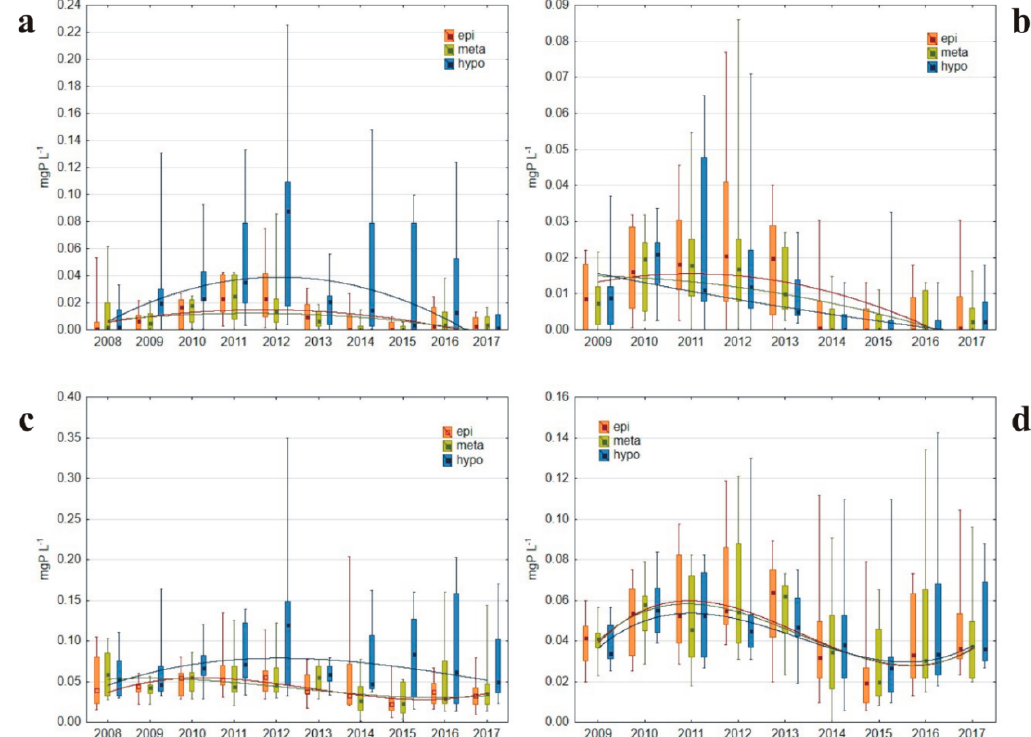
Figure 10. Box plot with min-max of phosphorus compounds in selected water layers: SRP at Station I ( a ) and Station II ( b ); and total P at Station I ( c ) and Station II ( d ). The lines indicate binomial trendlines for water layers at a and b, and polynomial trendlines for water layers at c and d.